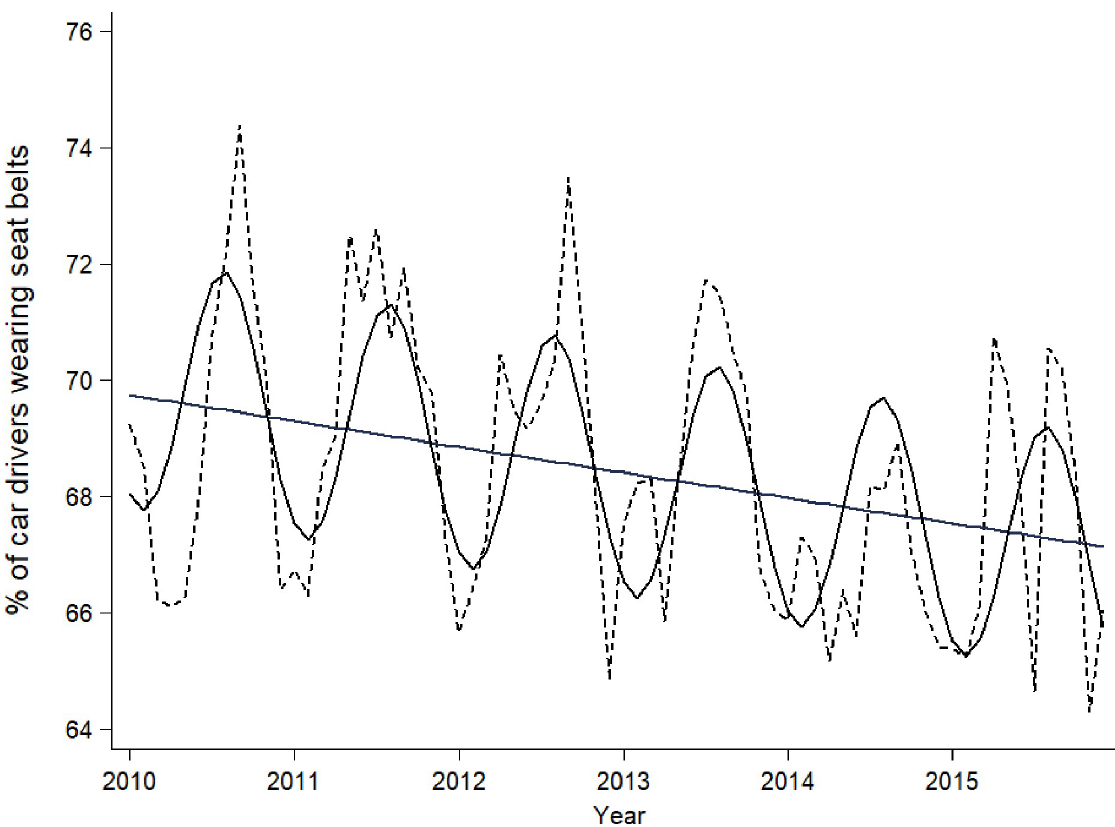
Fig 2. Actual (solid line) and fitted (broken line) proportion of car drivers wearing SB in the area of Florence, Italy, in